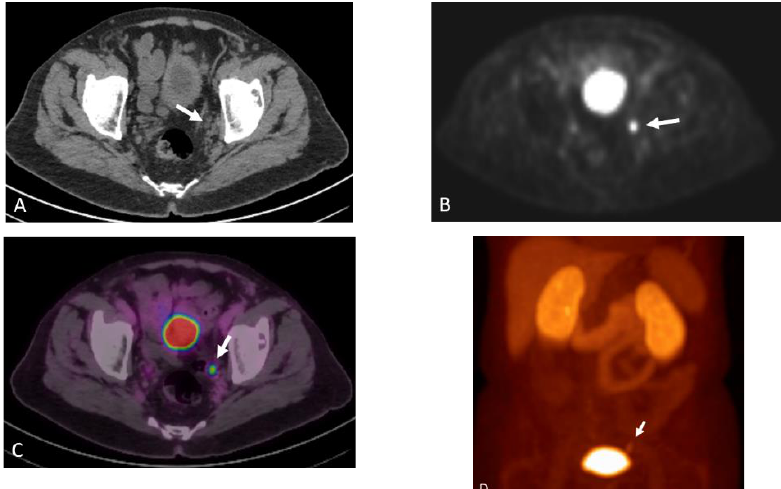
Figure 18. NECT ( A ), 18F DCFPyL PET ( B ), and fused PET/CT ( C ) images show curvilinear soft tissue, which demonstrate low-grade uptake (arrows). The location is characteristic for the celiac ganglion, a normal anatomic structure that can be mistaken for a pathologic lymph node.